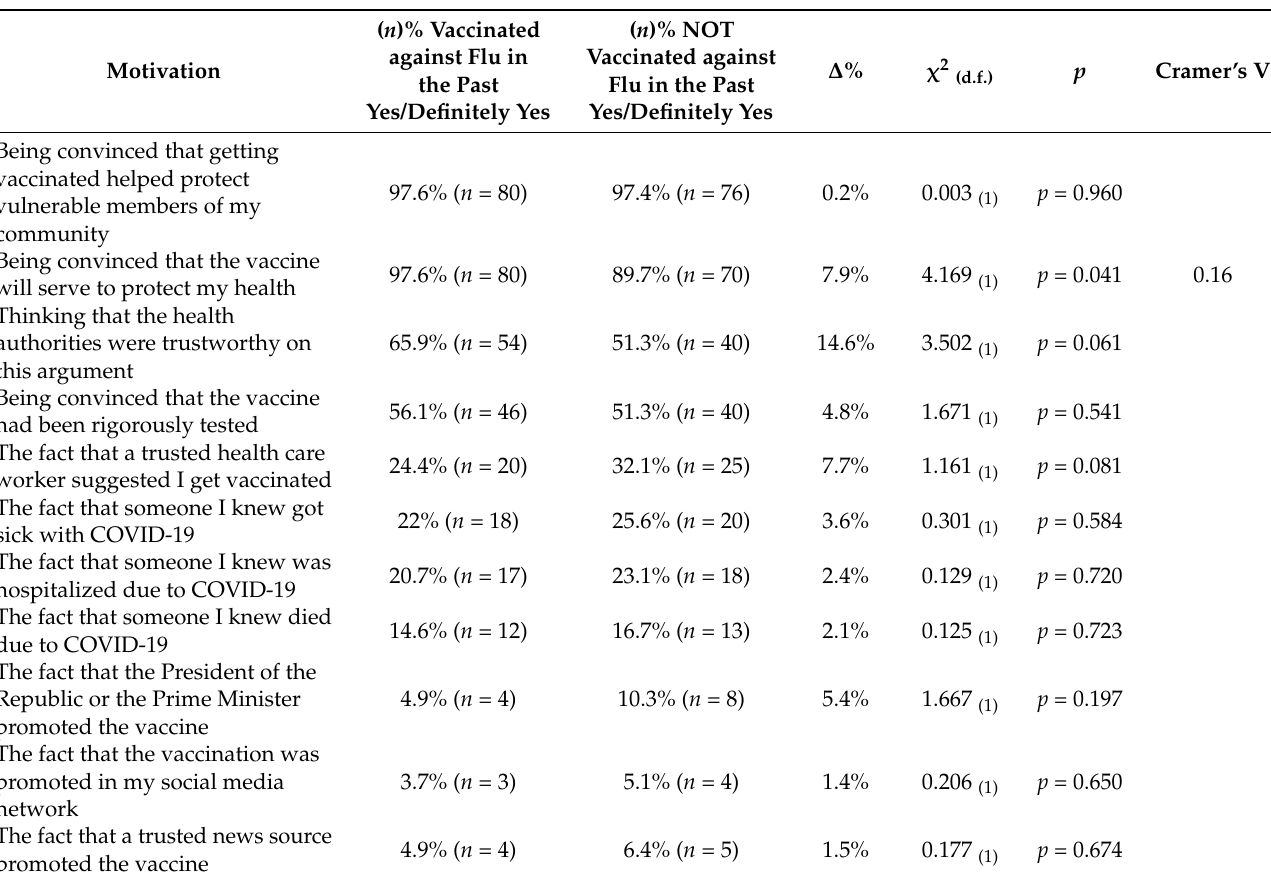
Table 3. Flu vaccination acceptance and motivations behind COVID-19 vaccination behaviors ( n = 160).